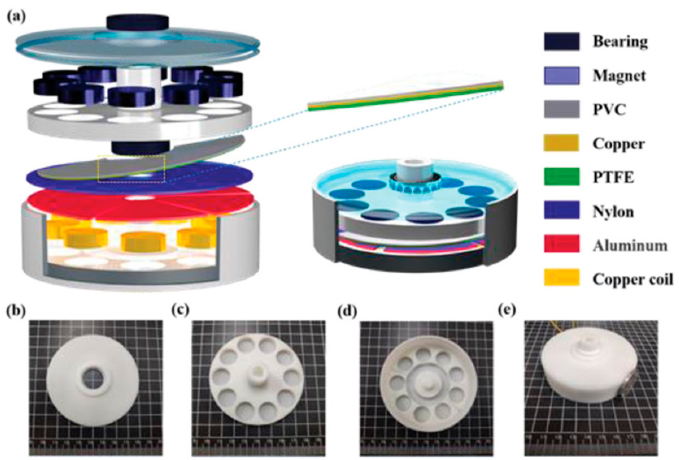
Figure 7. The TEHG structure developed by Zhao et al. [156]. ( a ) Schematic view of the main components and materials of the TEHG. ( b ) Image of the sealing cover of the cylindrical shell. ( c ) Image of the rotor disk. ( d ) Image of the cylindrical shell. ( e ) Image of the assembled structure of the TEHG. Reprinted with permission from [156]. Copyright 2021, John Wiley and Sons.